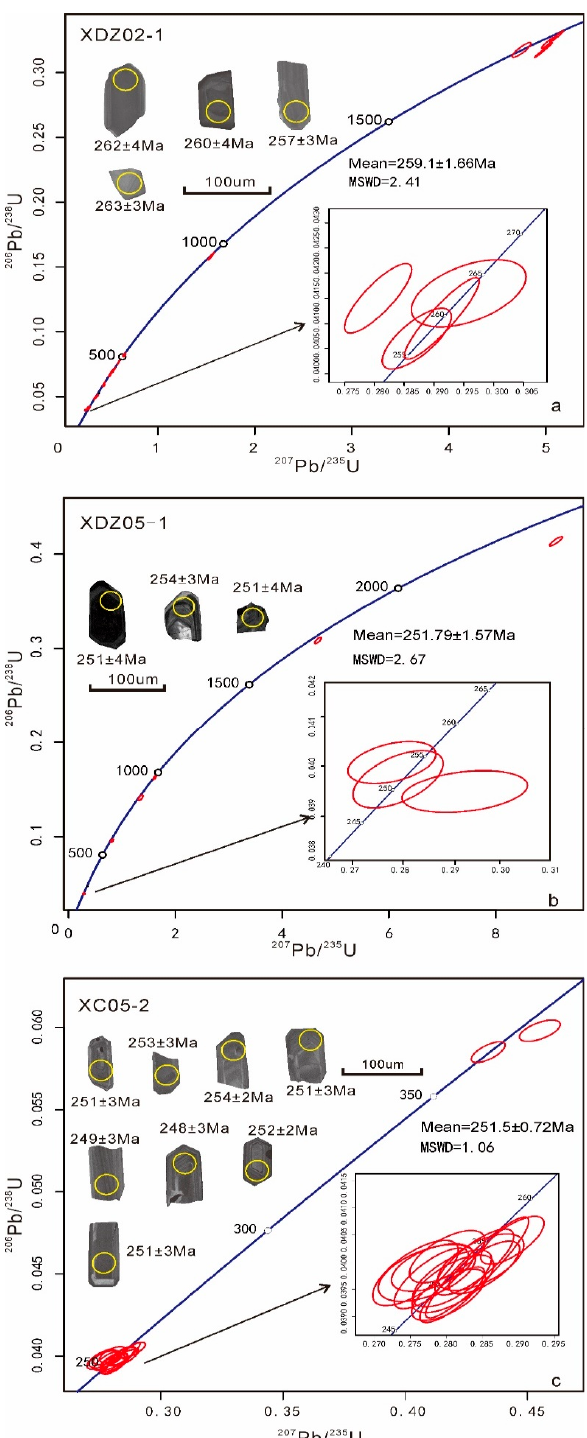
Figure 4. ( a – c ) SIMS zircon U-Pb concordia diagram, and corresponding CL images of repre sentative zircons for basalt sample XDZ02-1 and tuff samples XDZ05-1 and XC05-2 (circles refer to analyzed spots). Basalt sample XDZ02-1 was collected in Section 1. Zircons from XDZ02-1 mostly have a long prismatic shape with oscillatory zonation in CL images, lengths ranging from 50 to 110 µ m, and ratios of length to width ranging from 1:1 to 4:1 (Figures 2 and 4b). These zircons are generally high in Th and U concentrations with Th/U ratios varying from 0.28 to 0.91 and an average of 0.60, reflecting magmatic origin [51–55]. Four zircon grains